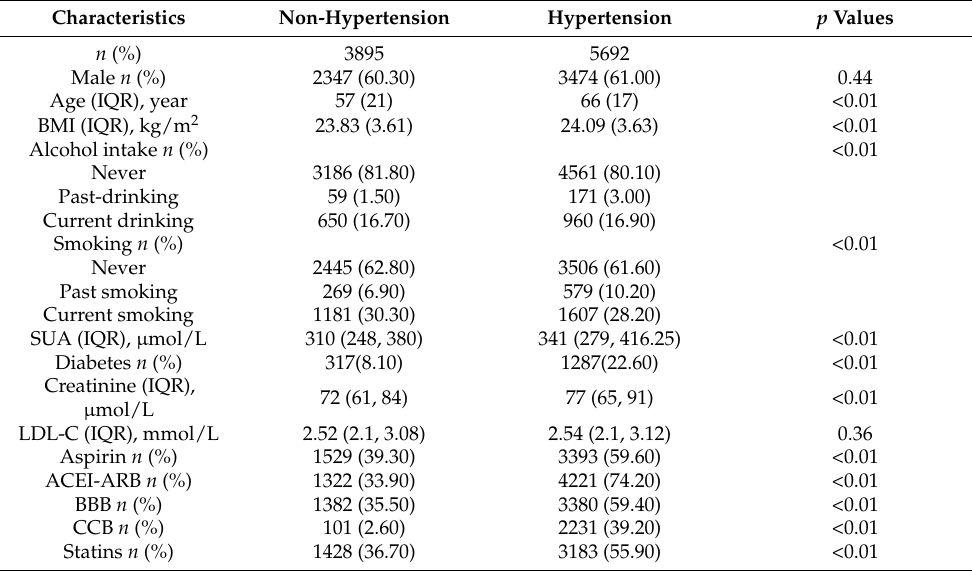
Table 1. Baseline characteristics of individuals grouped by presence or absence of hypertension.